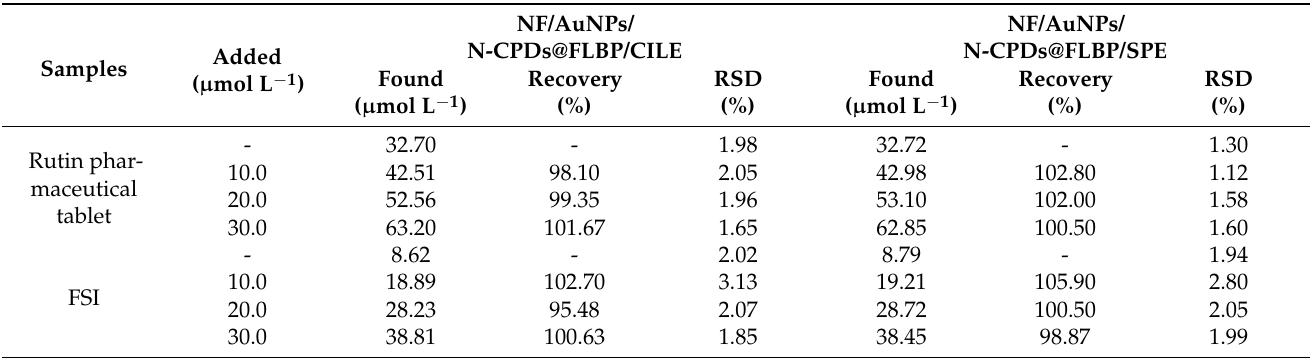
Table 2. Determinations of rutin in real samples using NF/AuNPs/N-CPDs@FLBP/CILE